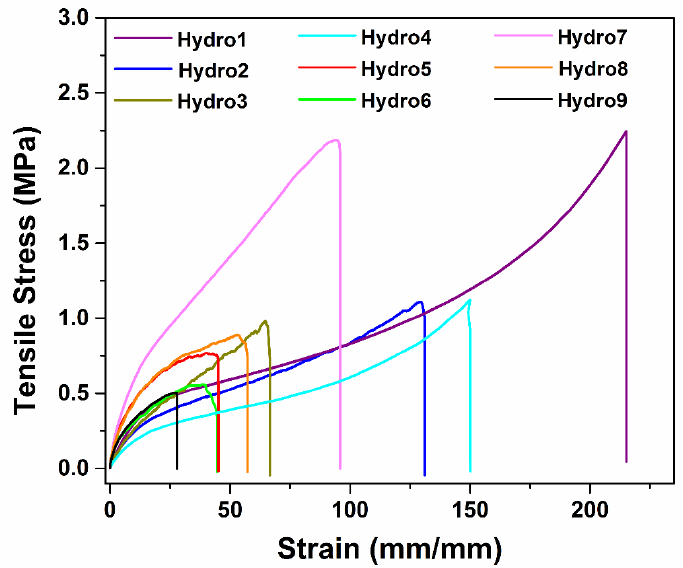
Figure 7 . Mechanical properties of synthesized hydrogels. Figure 7. Mechanical properties of synthesized Table 1. Mechanical properties of hydrogels synthesized at different doses and monomer concen-